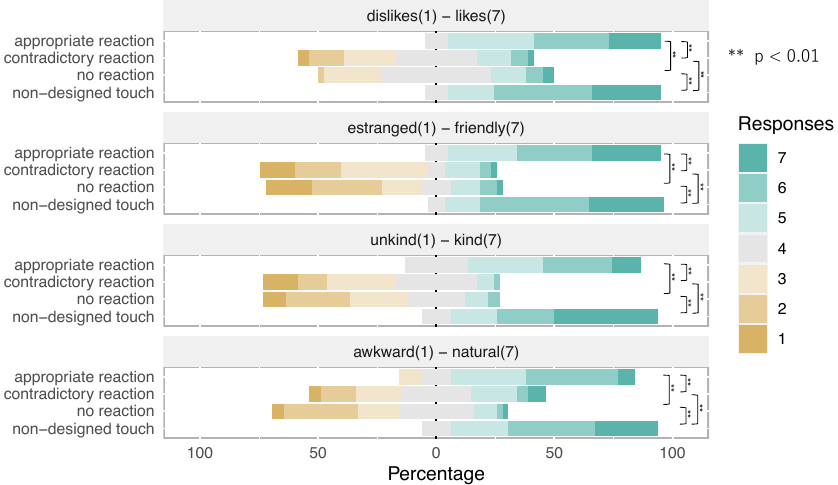
Figure 5. Results of questionnaire responses after each session (1/4): degree of liking toward the robot.